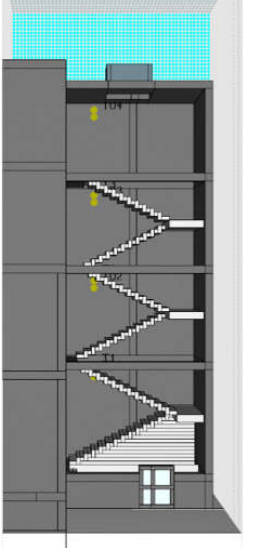
Figure 10. LabFactor K2 staircase